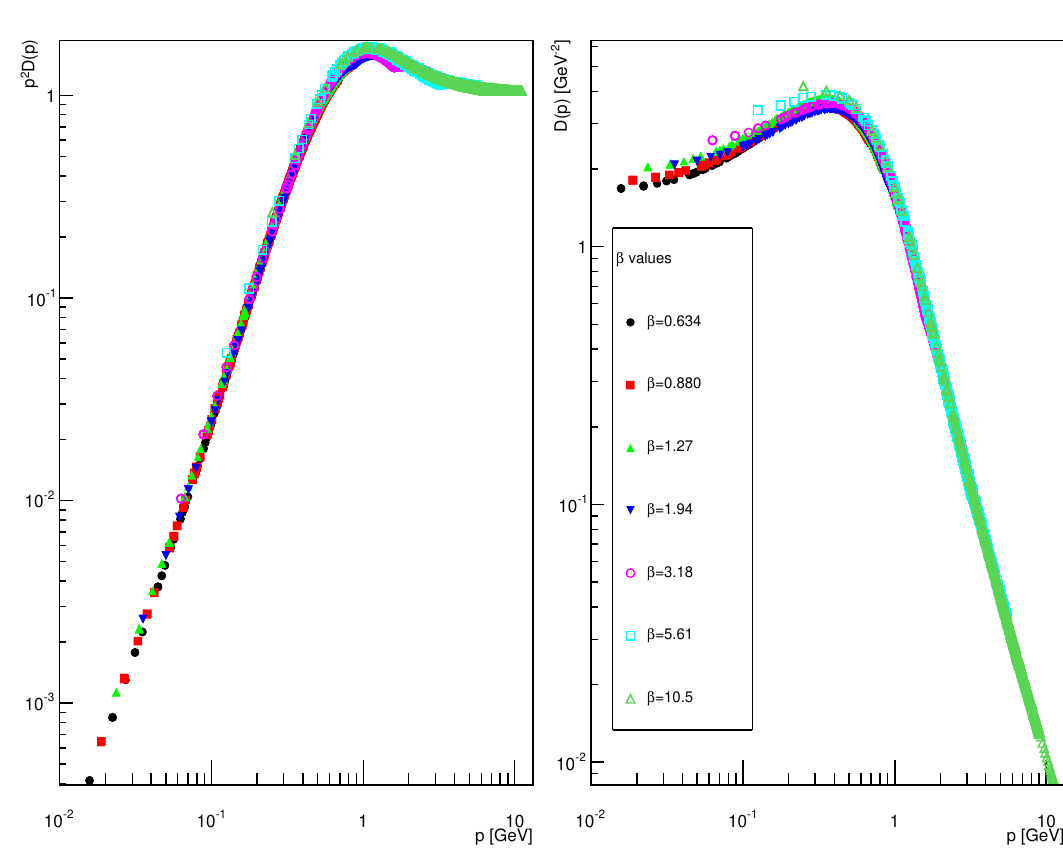
Figure 8: The gluon dressing function (left panel) and the gluon propagator (right panel) for the 80 3 lattice volumes for all β values, using the lattice spacing in table